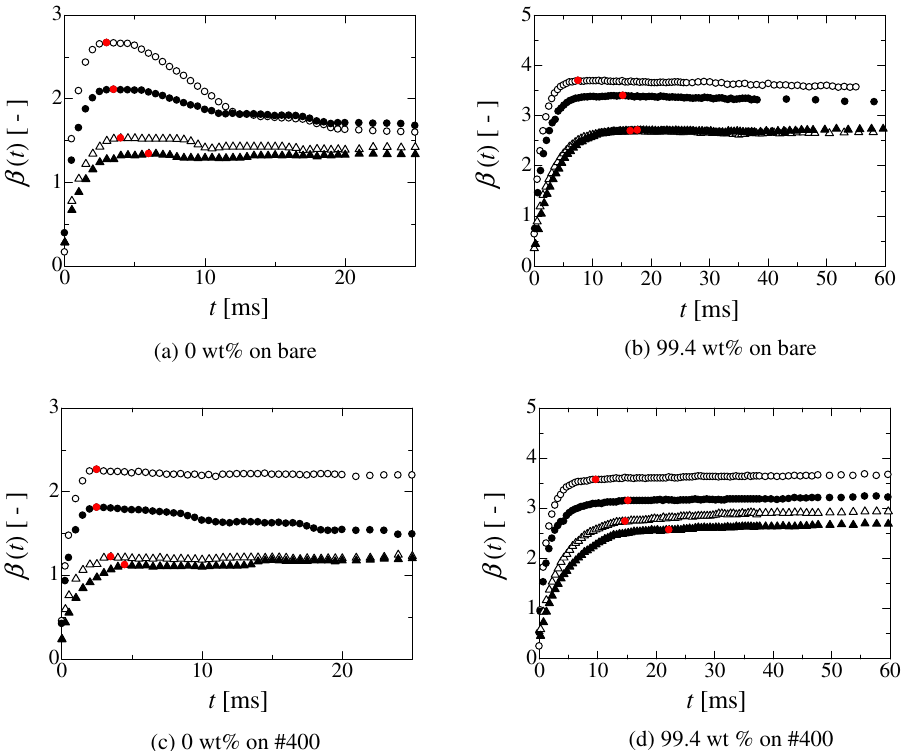
Figure 2. Time evolution of normalised contact-area diameter β ( t ) just after impingement (Magnified image for the earlier stage in Fig. S1). Red solid circle represents the first stationary point where d β ( t )/d t ≈ 0. the solid triangle, open triangle, open circle and solid circle represent the release heights of the droplet from 5, 10, 50, and 100 mm, respectively. The droplet is released from each height with no initial